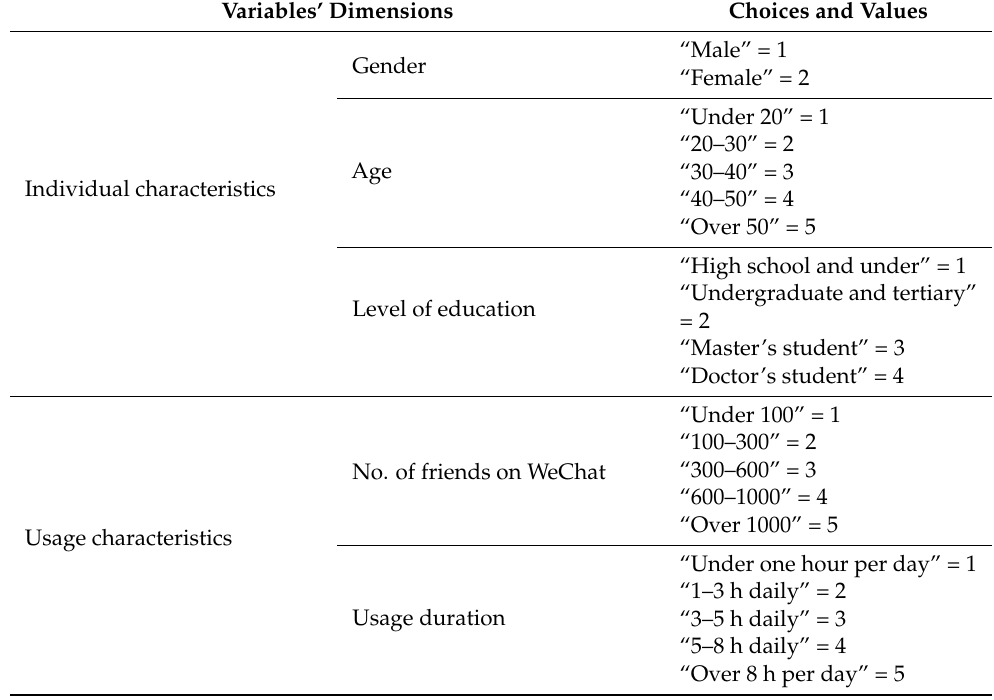
Table 2. Measurement indicator system for variables of individuals and usage characteristics.